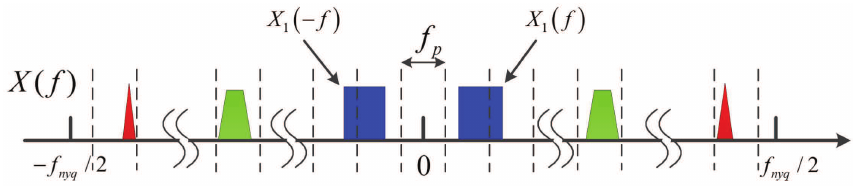
Figure 12. Schematic of a signal occupying two